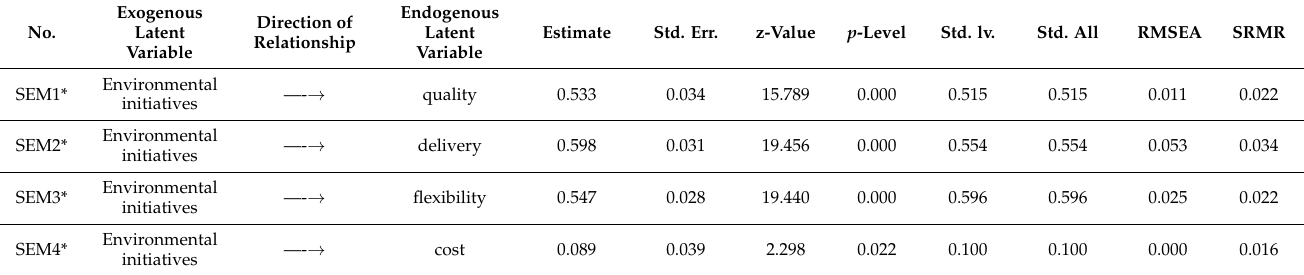
Table 2. Interactions between environmental initiatives and factors of